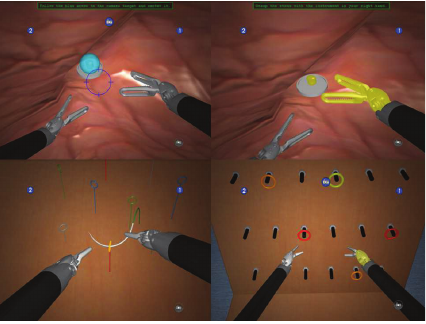
Figure 2: Exercises (exercises used in this study: “Camera Target- ing,”“ThreadtheRings,”and“PegBoard”(imageprovidedbyMimic Technologies, Inc., Seattle,